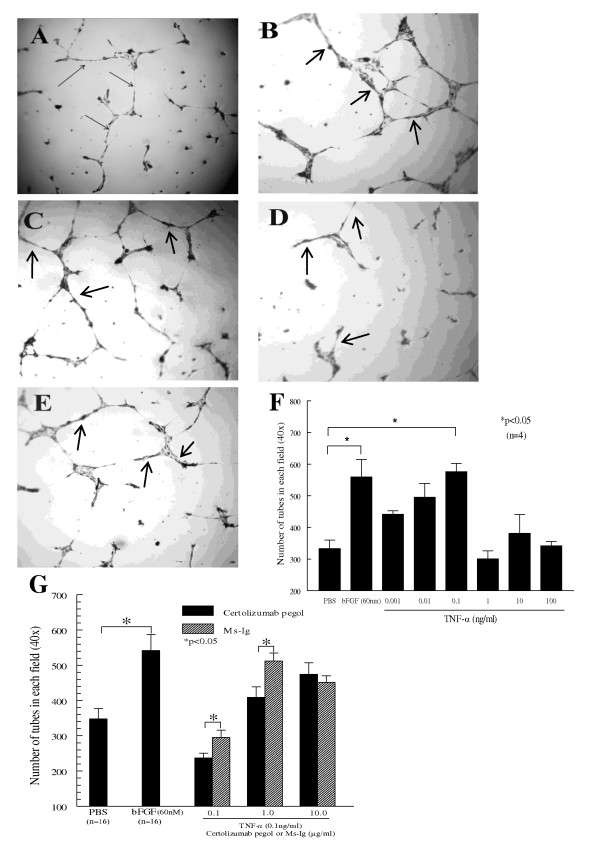
Certolizumab pegol inhibits TNFα-induced endothelial cell tube formation in Matrigel. Photomicrographs (×40) of representative wells are shown. The increase in tube formation in the TNFα-induced human dermal microvascular endothelial cell (HMVEC) group and the decreased angiogenesis in certolizumab pegol groups are shown as well as the control groups: (A) PBS, (B) basic fibroblast growth factor (bFGF; 60 nM), (C) TNFα (0.1 ng/ml), (D) TNFα (0.1 ng/ml) in the presence of certolizumab pegol (0.1 μg/ml), and (E) TNFα (0.1 ng/ml) with mouse-IgG (Ms-Ig; 0.1 μg/ml). Arrows represent the endothelial cell (EC) tube formation in Matrigel. (F) HMVECs form significantly greater number of tubes in Matrigel in response to TNFα at 0.1 ng/ml (94% increase) versus the PBS control group (*P < 0.05). (G) HMVECs were plated in Matrigel and incubated with either PBS (negative control), bFGF (60 nM; positive control) or TNFα (0.1 ng/ml) with graded concentrations of certolizumab pegol (0.1 μg/ml, n = 7; 1.0 μg/ml, n = 8; or 10.0 μg/ml, n = 4) or, for comparison, Ms-Ig (0.1 μg/ml, n = 8; 1.0 μg/ml, n = 4; or 10.0 μg/ml, n = 4). As shown, certolizumab pegol (0.1 or 1.0 μg/ml) blocks TNFα-induced EC tube formation in Matrigel compared with the Ms-Ig control groups (33% and 30% decreases in tube formation, respectively; *P < 0.05; n, number of independent experiments performed). For all sets of experiments, means of the number of tubes per well are given ± standard error of the mean.